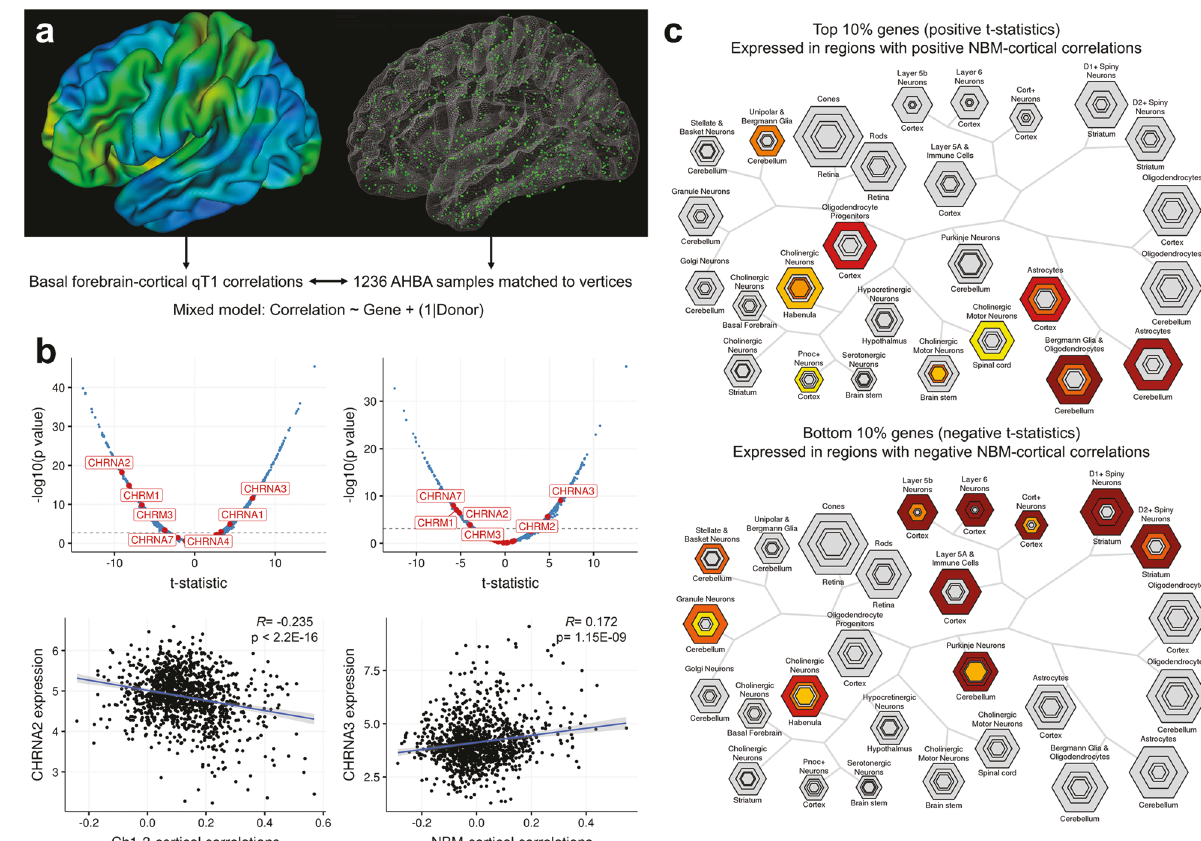
Fig. 5 Using transcriptomics to explain neuroimaging correlations. a Coloured cortical surface (left) shows Pearson ’ s R correlations between Ch1-3 qT1 and intracortical qT1. On the right surface, 1236 AHBA cortical samples assigned to a unique vertex are shown. Using a mixed effects model, we sought to explain BF-cortical correlations by gene expression with donor as a random factor. b Top: Volcano plot with distribution of t-statistics ( x -axis), with dotted line indicating signi fi cance at FDR q <0.05. Labelled genes are cholinergic receptor genes signi fi cant after FDR correction, for the Ch1-3 (left) and NBM (right). Bottom: example of imaging-genetic correlations for 2 of the most signi fi cant genes. c CSEA of the top 10% (highly expressed in regions with positive NBM-cortical correlations) and bottom 10% genes (highly expressed in regions with negative NBM-cortical correlations) highlights relative enrichment of glial cells in regions with positive imaging